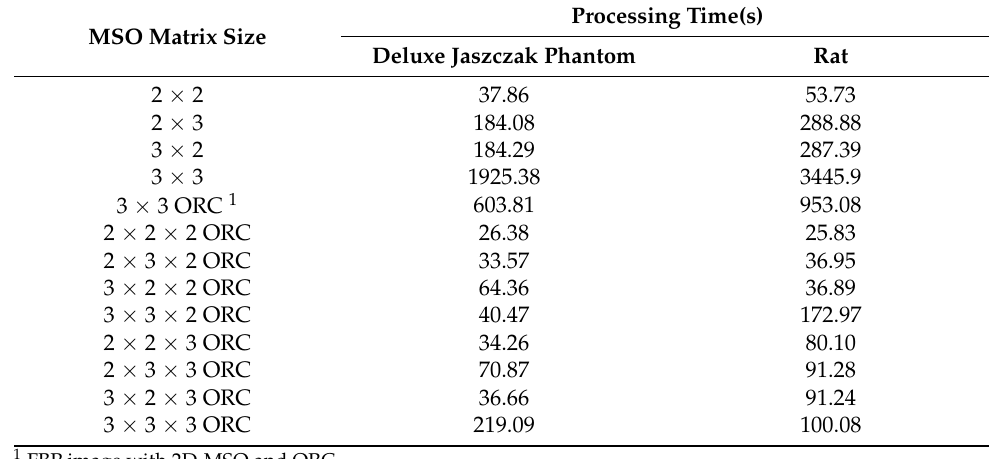
Table 5. The computational time in seconds by 2D- and 3D-MSO operation.